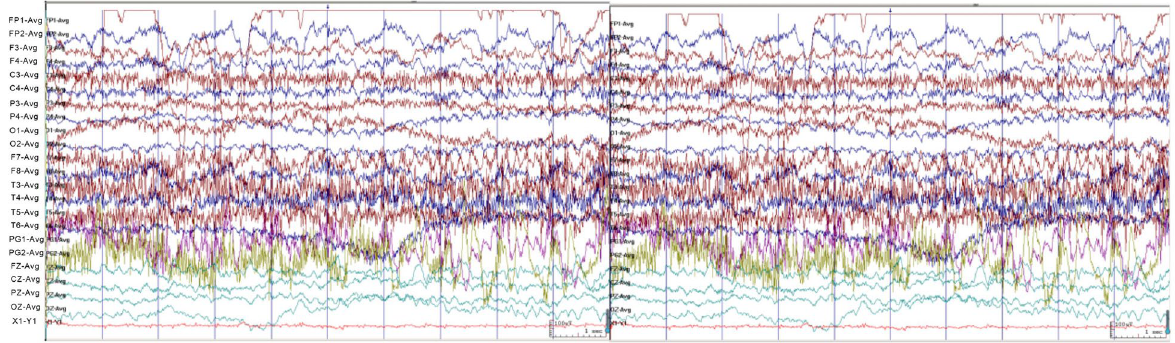
Fig. 3 EEG recordings during a seizure. The EEG traces showed fast-wave activity in bilateral temporal areas, significant on the left, and then evolved into sharp-wave rhythms in the left temporal area, frontal pole, and frontal area, and finally spread to the whole lead, showing slow-wave rhythm